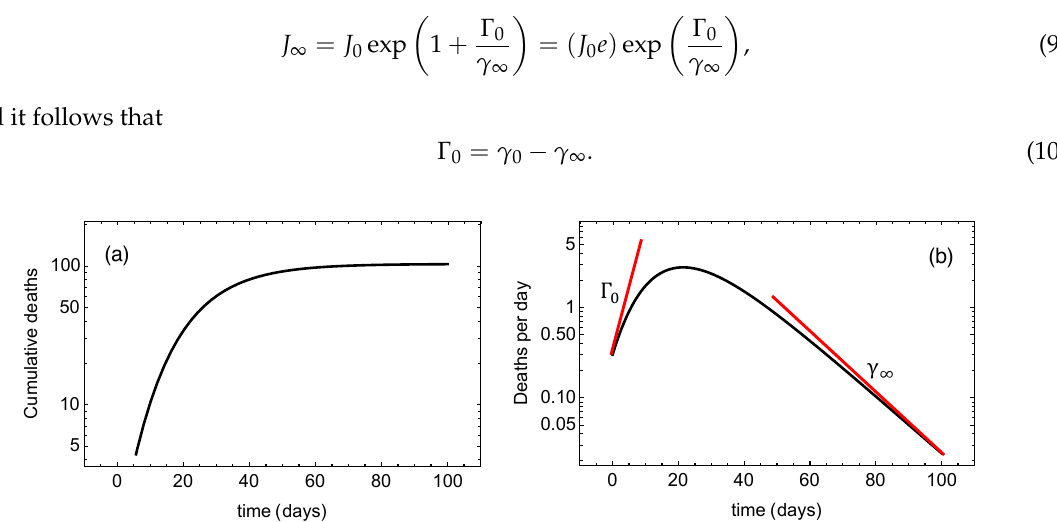
Figure 1. ( a ): Evolution of cumulative deaths per million J ( t ) in a log-plot expressed as a Gompertz function. ( b ): The evolution of the daily death number d t J ( t ) in a log-plot with the tangents at t = 0 and t = ∞ marked. The slopes of these tangents are Γ 0 and γ ∞ ,